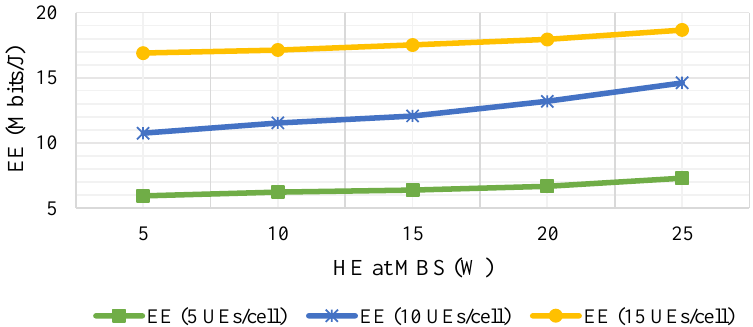
Figure 10. Effects of the MBS as sole access point on EE for various MBS HE and number of UEs per cell.